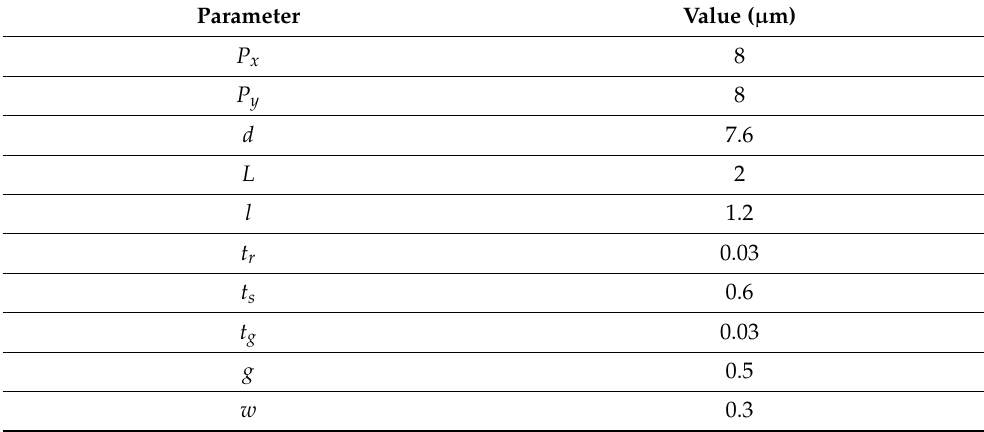
Table 1. The estimated parameters of the proposed design at optimum condition.